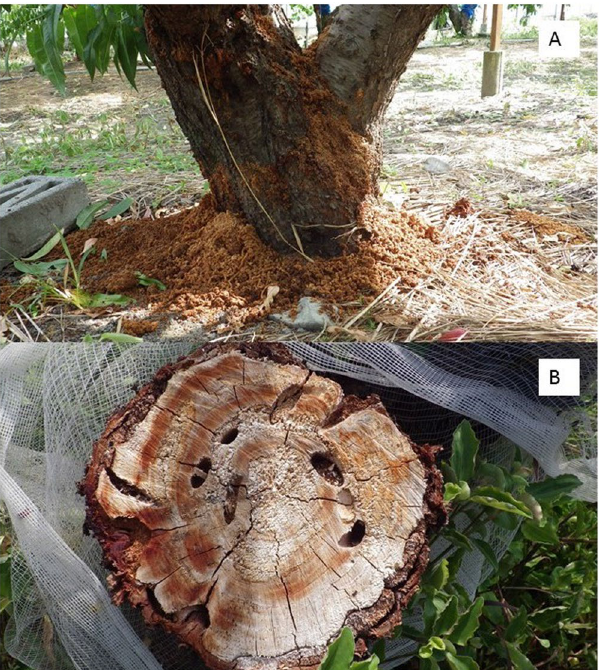
Figure 2. ( A ) A peach tree infested by A. bungii (Tokushima Prefecture, Japan, August 2016), showing the voluminous frass produced by the feeding larvae; ( B ) structural damage to the trunk caused by developing larvae feeding in the nutrient-rich phloem and tunneling in the